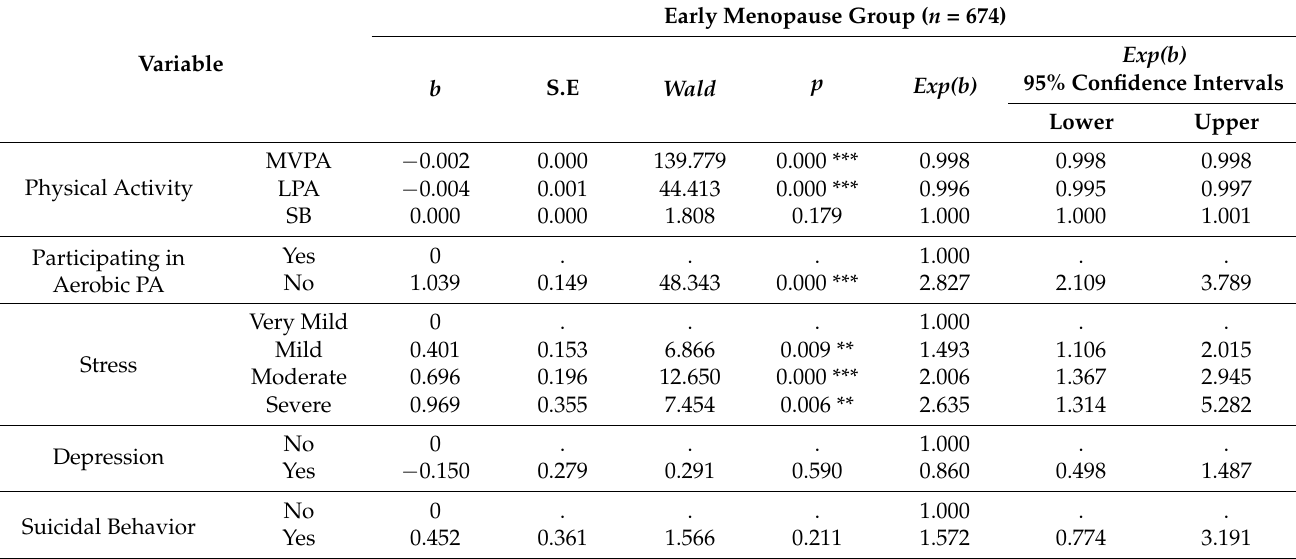
Table 2. Multinomial logistic regression of factors in stress and participating in aerobic physical activity.